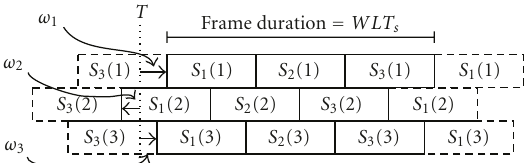
Figure 3: Example of cluster frames and synchronization